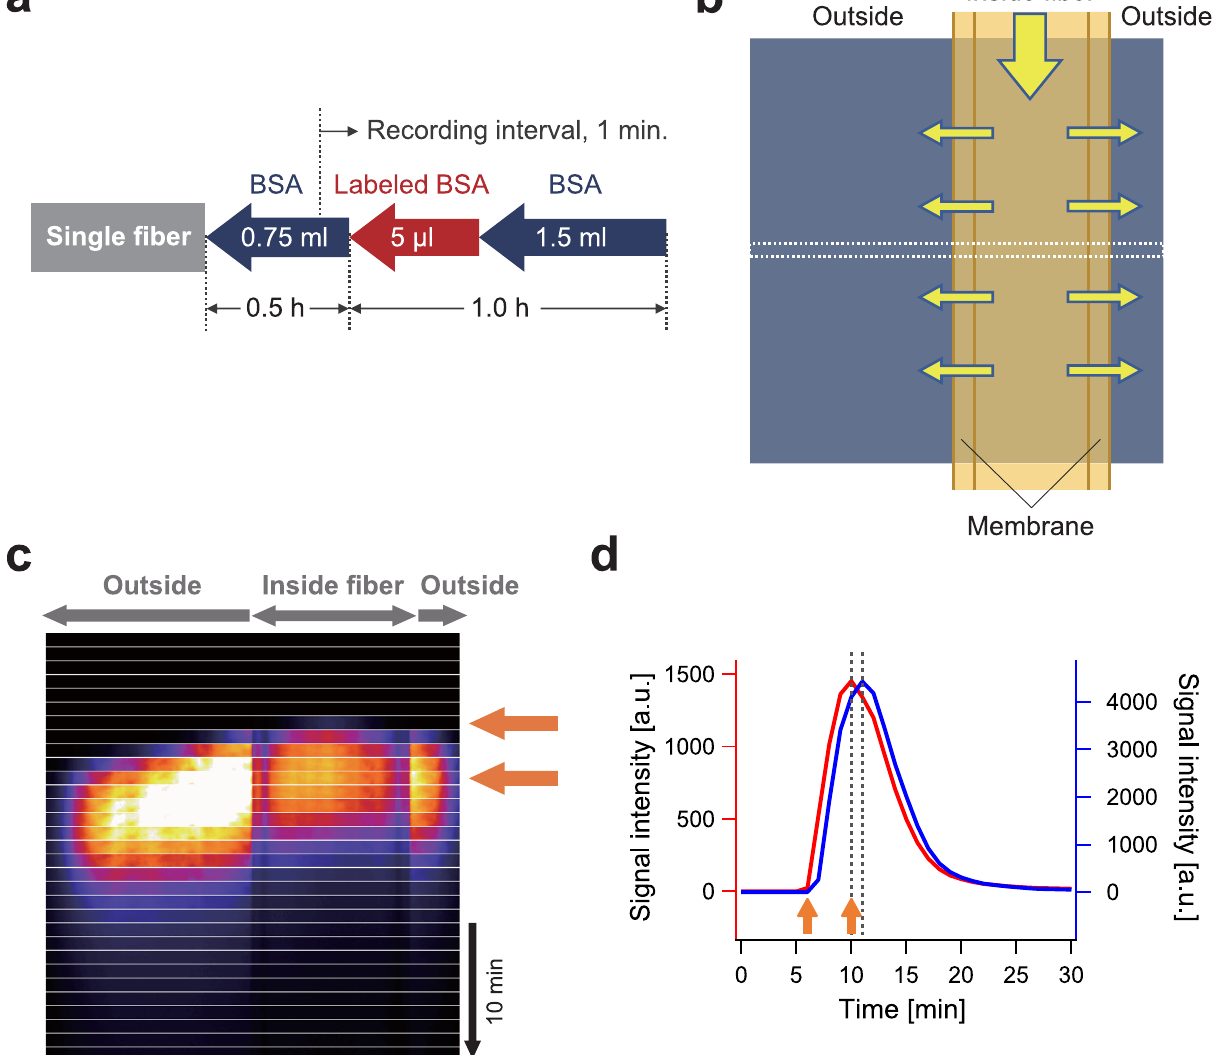
Figure 3. Behavior of a model protein passing through the membrane. ( a ) Diagram showing shot injection of the fluorescently labeled BSA. After equilibration of the solution containing 10 mg mL −1 of unlabeled BSA, 5 µL of BSA labeled with 20 µM fluorophore was infused as a single shot, and subsequently unlabeled BSA were infused. ( b ) Schematic diagram of the observation in a single image. ( c ) Image sequence comprising narrow bands aligned in the y -axis. Images were taken at 1-min intervals. The top arrow shows the frame when fluorescence started to appear inside the fiber. The bottom arrow shows the moment of peak signal intensity inside the membrane. Scale bar, 300 µm. ( d ) Time course of the change in intensity inside (red) and outside (blue) the membrane. Two dotted lines represent the times of peak signal